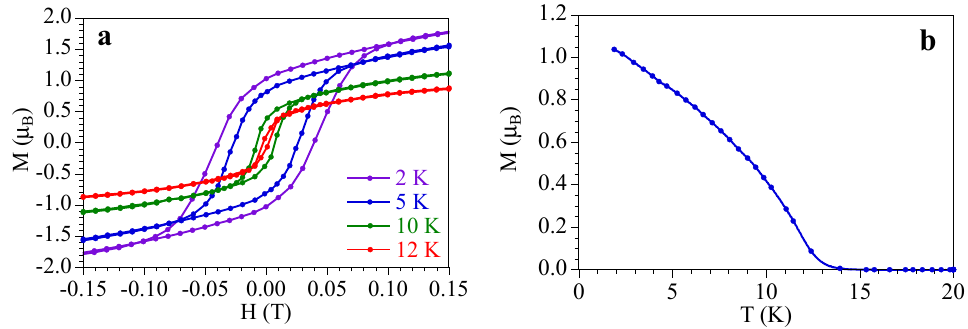
Figure 7. ( a ) Hysteresis cycles at different temperatures for compound 1 . ( b ) Thermal variation of the remnant magnetization of compound 1 after cooling the sample under 5 T.